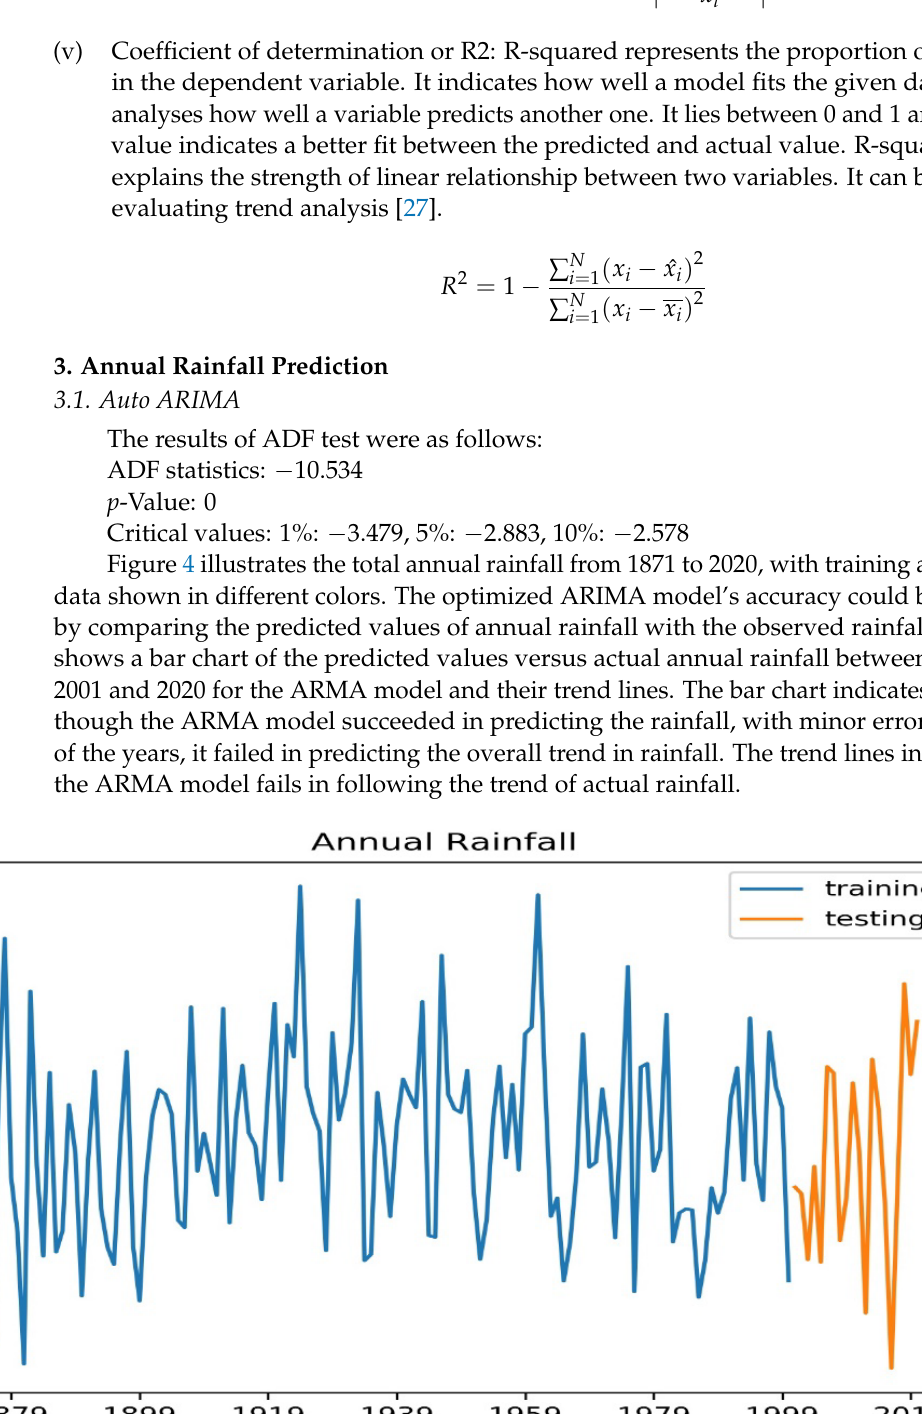
(v) Coefficient of determination or R2: R-squared represents the proportion of variance